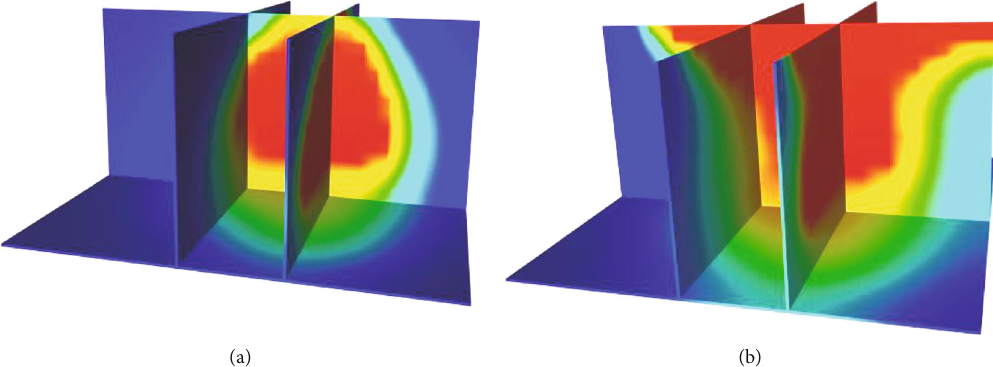
Figure 16: A three-dimensional diagram of the temperature fi eld in 3D physical experiment. (a) Middle stage. (b) End stage.